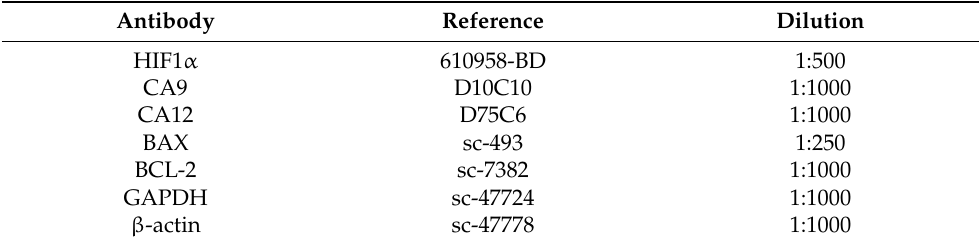
Table 1. Primary antibodies for Western blotting